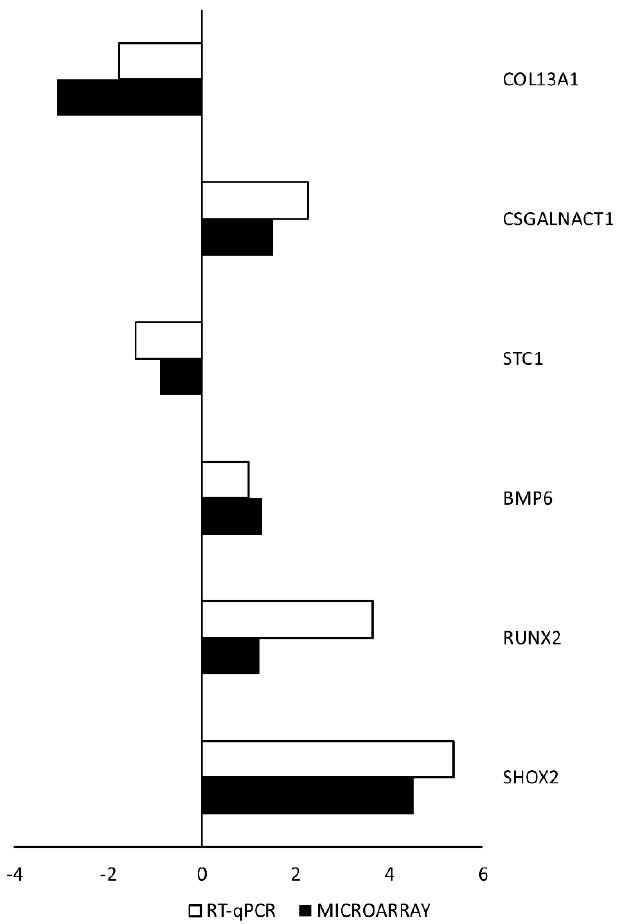
Figure 5. RT-qPCR quantitative validation of microarray results presented in a form of a bar graph. The graph shows the relative changes in gene expression results for veins, in relation to the transcript levels obtained from the ITA. FC was presented in its logarithmic form to provide clear comparability of the results.